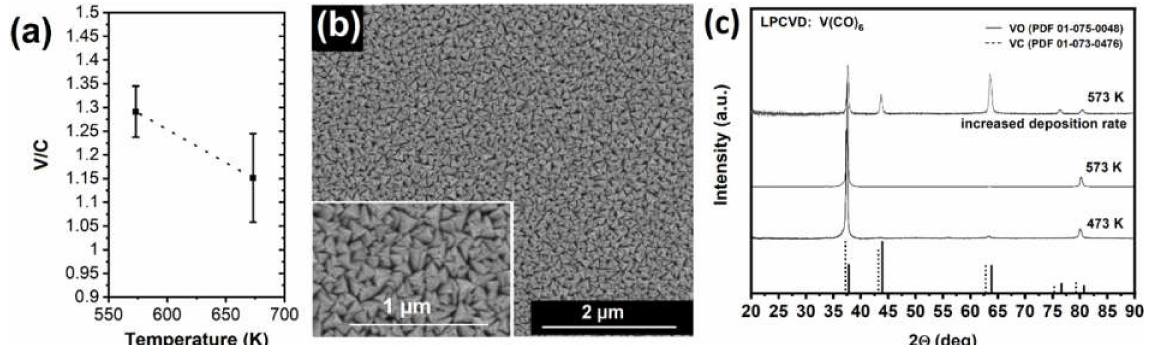
Figure 5. ( a ) Composition of CVD coatings determined by EDX for films prepared at different temperatures using V(CO) 6 as a precursor. The elemental V/C ratio is in all cases above 1. ( b ) SEM image shows a homogenous V-based CVD coating deposited at 573 K on Si (911). The inset shows grains with pronounced faceted morphologies on the surface of a film, which is grown at low precursor temperatures of 263 K. ( c ) XRD pattern recorded at room temperature for films grown at substrate temperatures ranging from 473 to 573 K showing preferred orientation. Increased deposition rate leads to deposits with a lower degree of orientation and crystal sizes, allowing an unequivocal identification of a cubic crystal phase corresponding to VC 1 − x O x